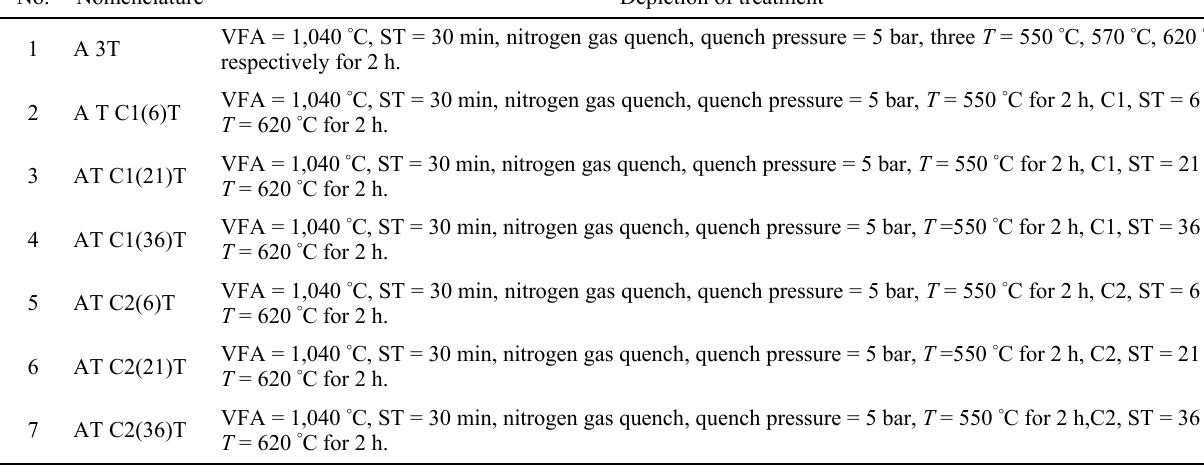
Table 2 Heat treatment sequence followed for HDS H13.